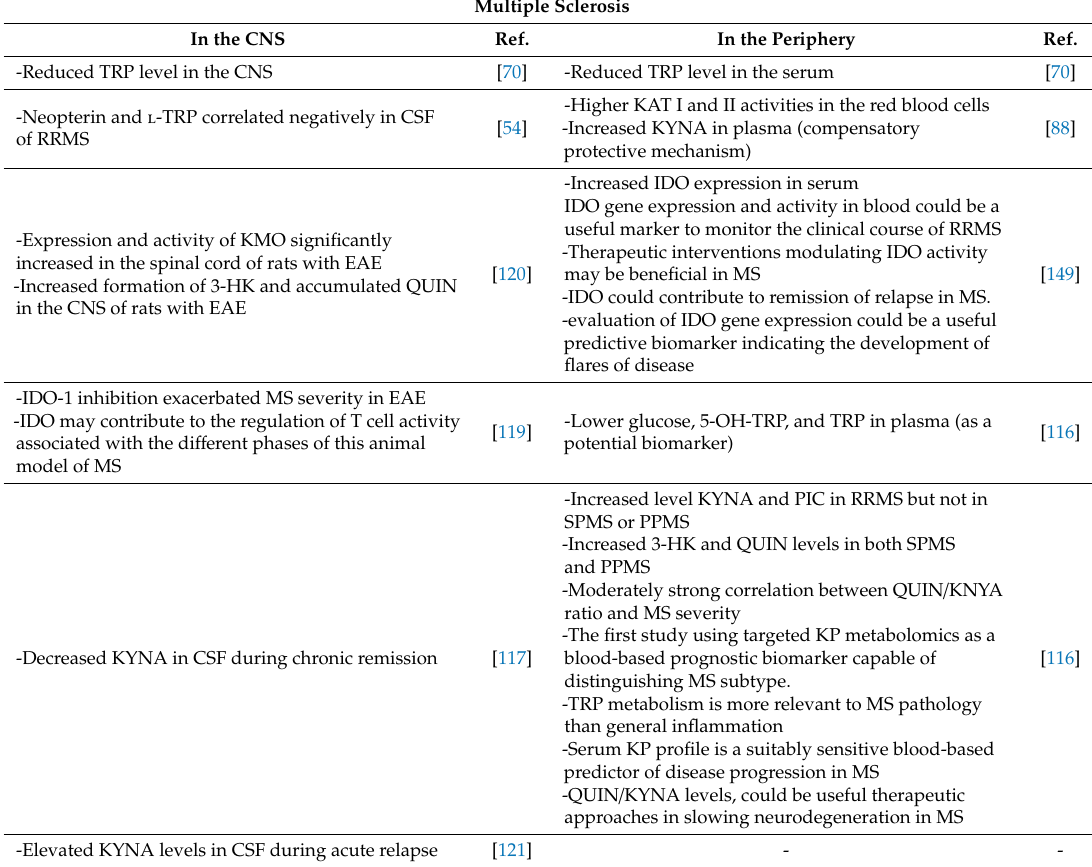
Table A5. Di ff erences of kynurenine pathways in the CNS and the periphery in multiple sclerosis. Multiple Sclerosis In the CNS Ref. In the Periphery